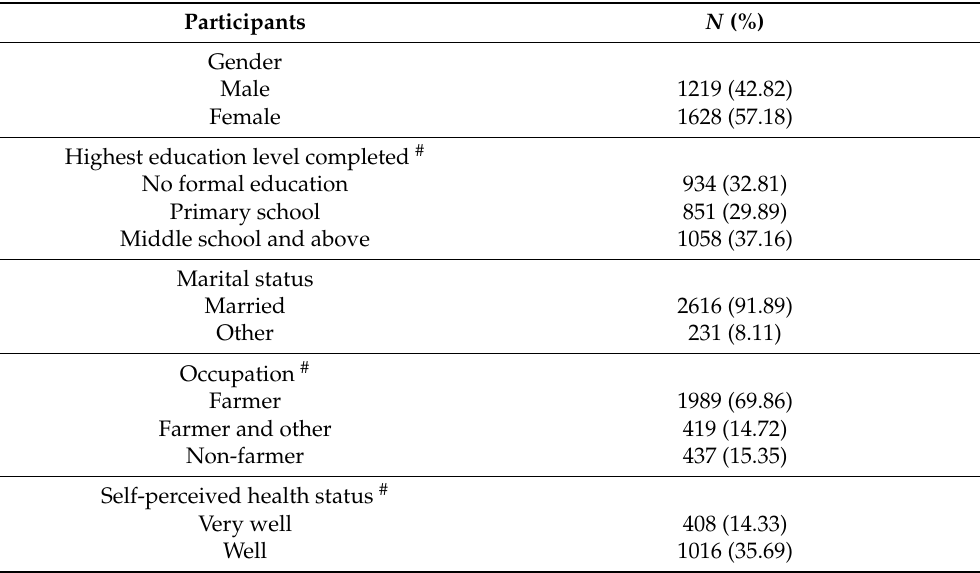
Table 1. Demographic information of